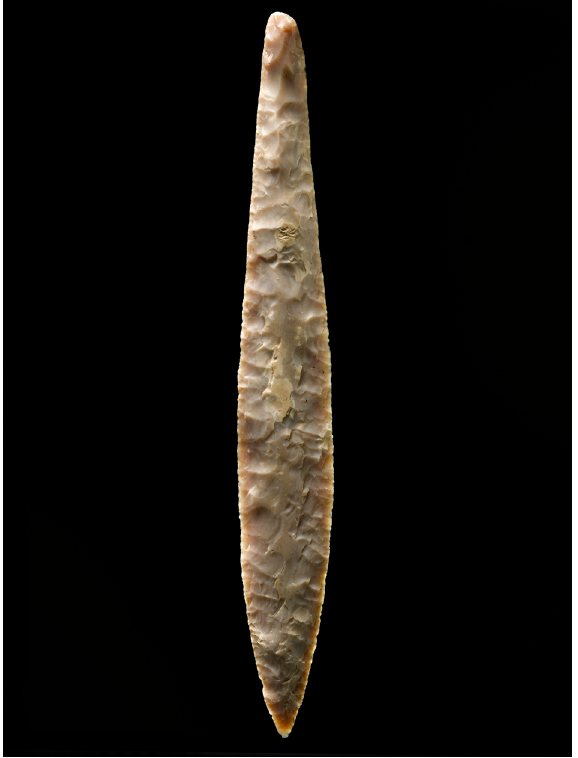
Figure 2. Flint dagger from Thy, northern Jutland. Photo: Roberto Fortuna and Kira Ursem, The National Museum of Denmark, licence CC